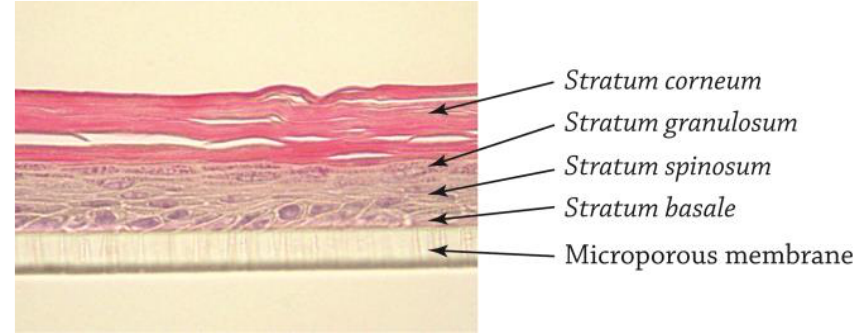
Figure 2. Histological evaluation of QileX-RhE model.